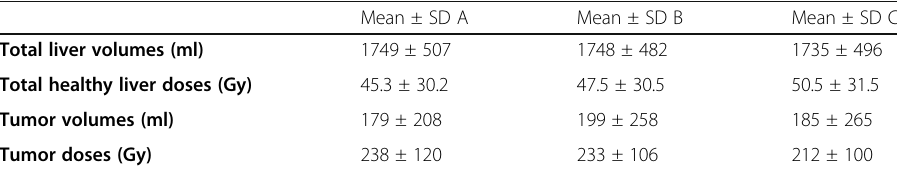
Table 3 Summary of mean values ± SD of TLV, THLD, TV, and